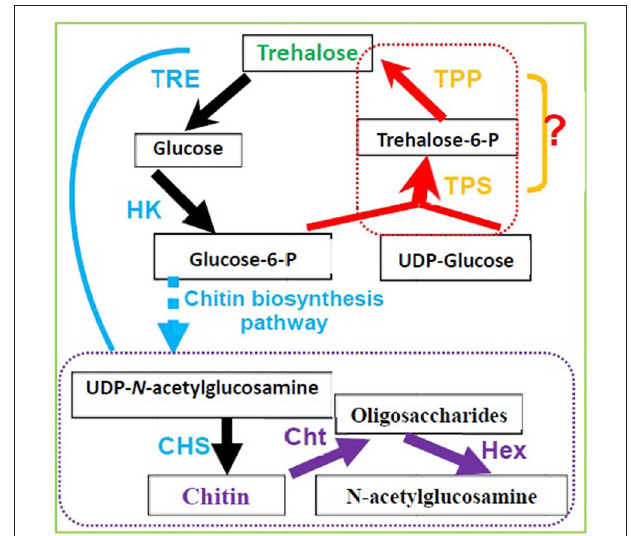
FIGURE 4 | Trehalose metabolism and its relevance to chitin biosynthesis and degradation in insects and and invertebrate animals. (TRE, Trehalase;